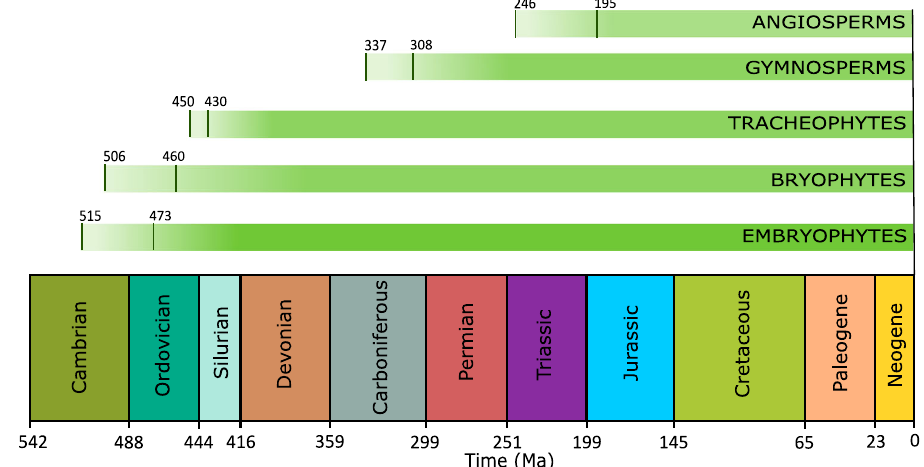
clock analysis 41 . Numbers on the timeline indicate the start of each Phanerozoic period; Ma: million years ago.